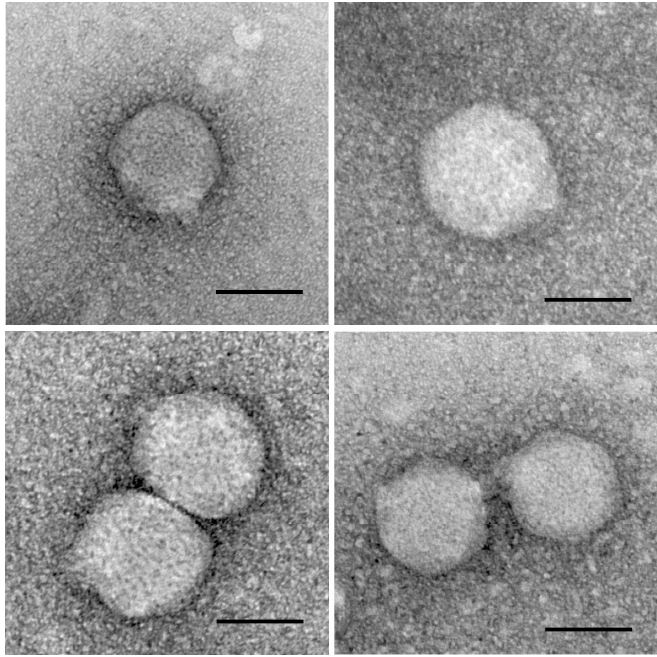
Figure 5. Transmission electron micrographs of the negative-stained gut-symbiotic Burkholderia phage BiBurk16MC_R, photographed in four different fields. Scale bars indicate 50 nm.